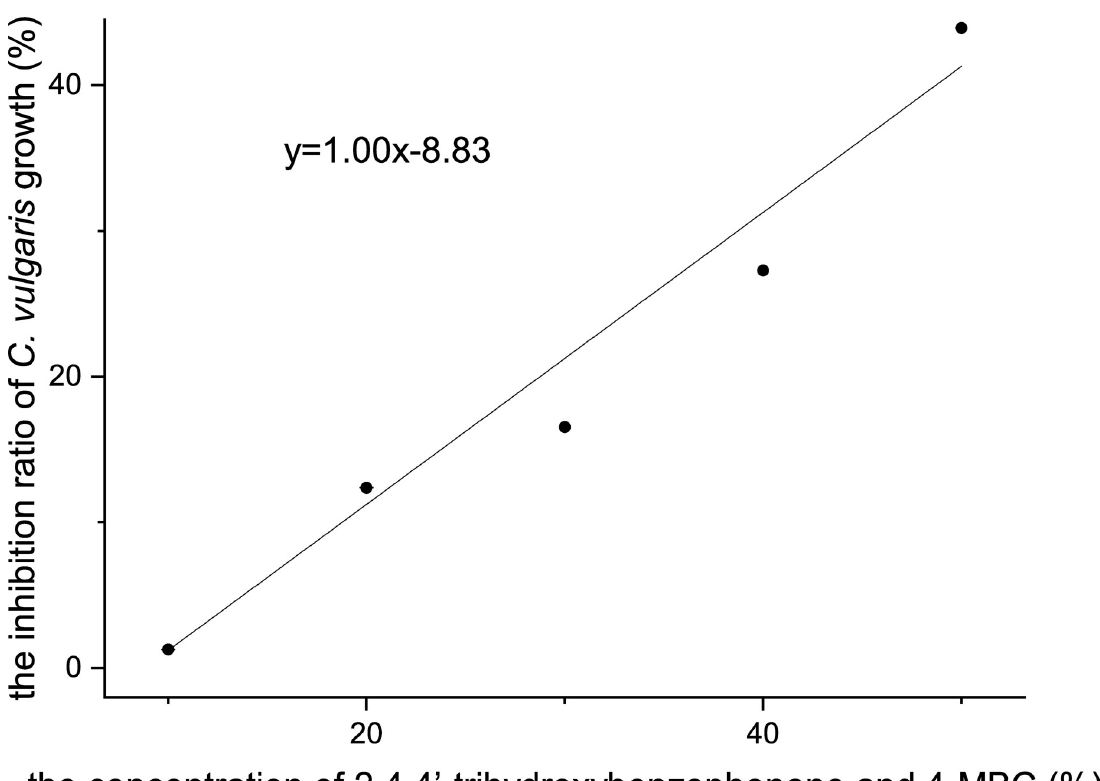
Fig 6. The inhibition ratio of C . vulgaris growth of a mixture of 2,4,4’-trihydroxybenzophenone and